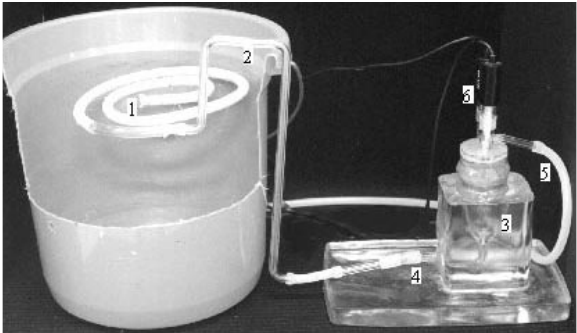
Figura 1. Sistema de extração da solução do solo acoplado à célula eletrométrica de determinação do potencial redox e pH. 1 Tubo de polietileno perfurado e recoberto com tela de nylon; 2 Tubo de vidro em forma de sifão; 3 Câmara eletrométrica; 4 Tubo de entrada e saída da solução; 5 Tubo de descarga do excesso de solução; 6 Eletrodos de medida do Eh e